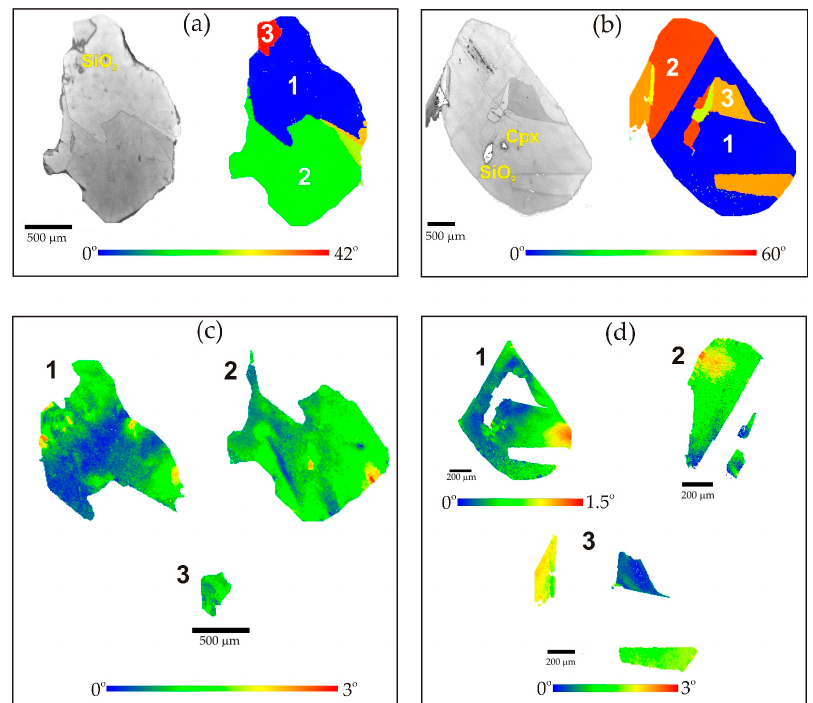
Figure 10. Misorientation patterns of super-deep diamonds with large misorientations of subindividuals from São-Luiz alluvial placers (Juina, Brazil). (left—reflected light, right—EBSD image, bottom—misorientation degrees). ( a,c ) SL-2; ( b,d ) SL-55. ( a , b ) EBSD maps over large parts of the polished plates showing a change in orientation. (c,d) EBSD maps of single subindividuals of samples.